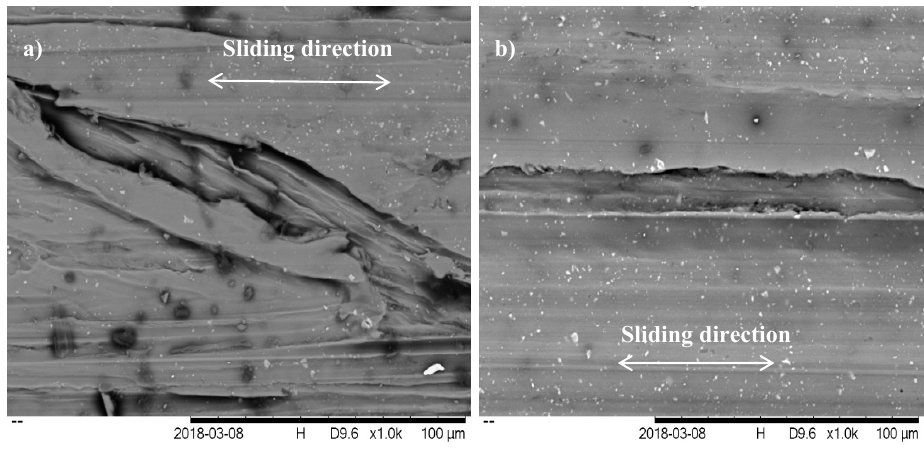
Figure 19. Wear morphologies at ( a ) SAE 40, ( b ) 0.5 CNC-CuO.